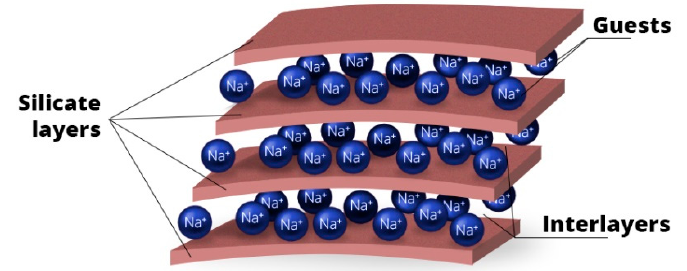
Figure 11. Layered structure of clays.